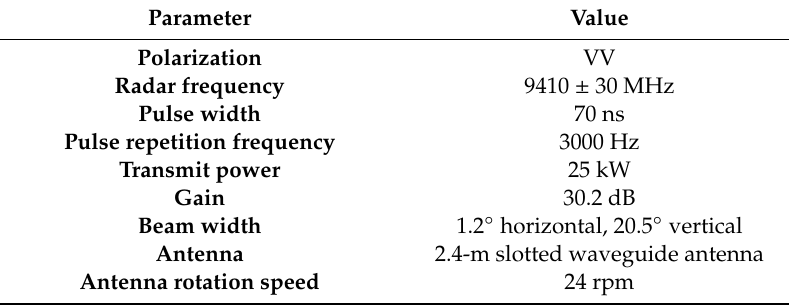
Table 1. Configurations of the X-band marine radar